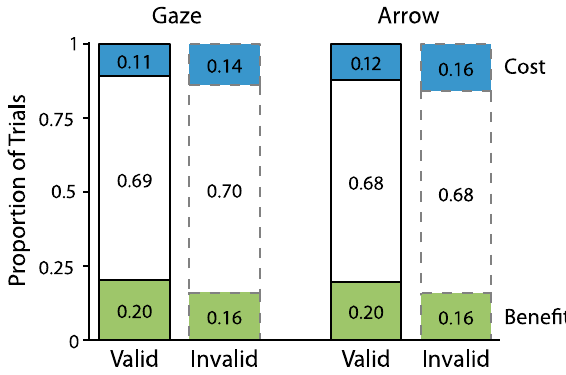
Figure 3. Cumulative proportion of trials for Experiment 1 classified as benefits (green), costs (blue), and the remaining trials (white).